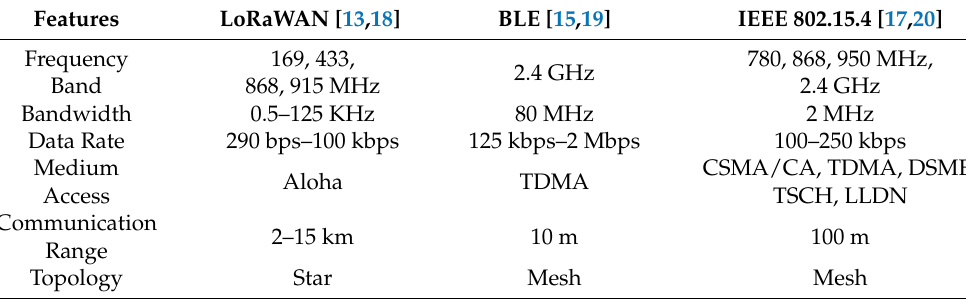
Table 1. Comparison of three wireless networking for industrial